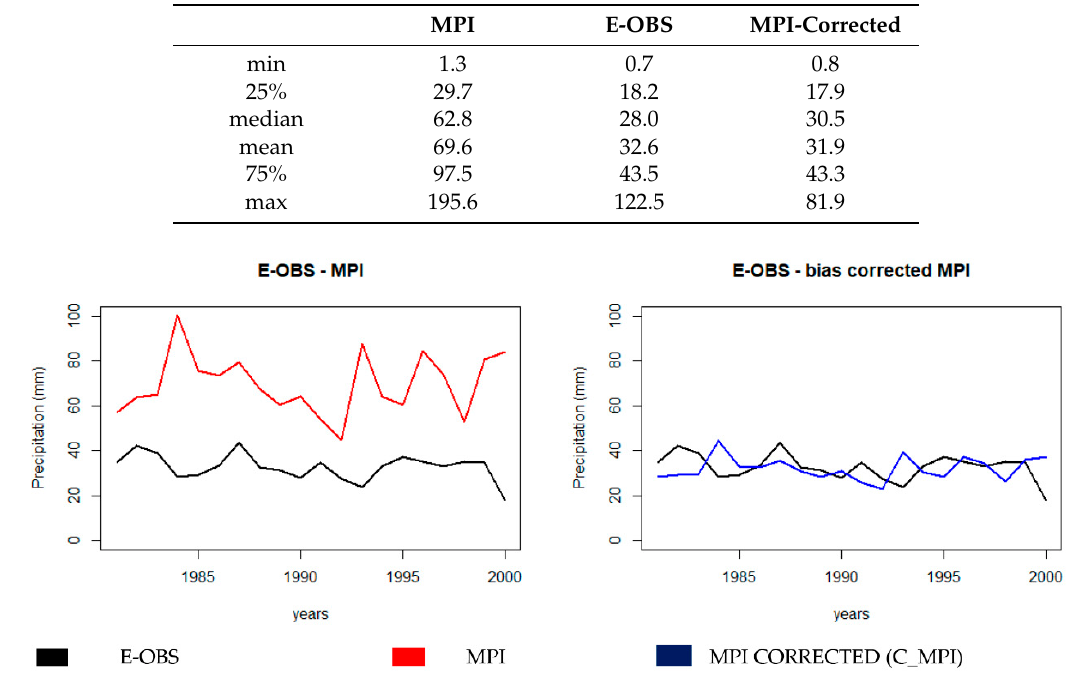
Figure 9. Line plots of the data series for the whole studied region and for the three datasets (MPI, E-OBS, and C_MPI).